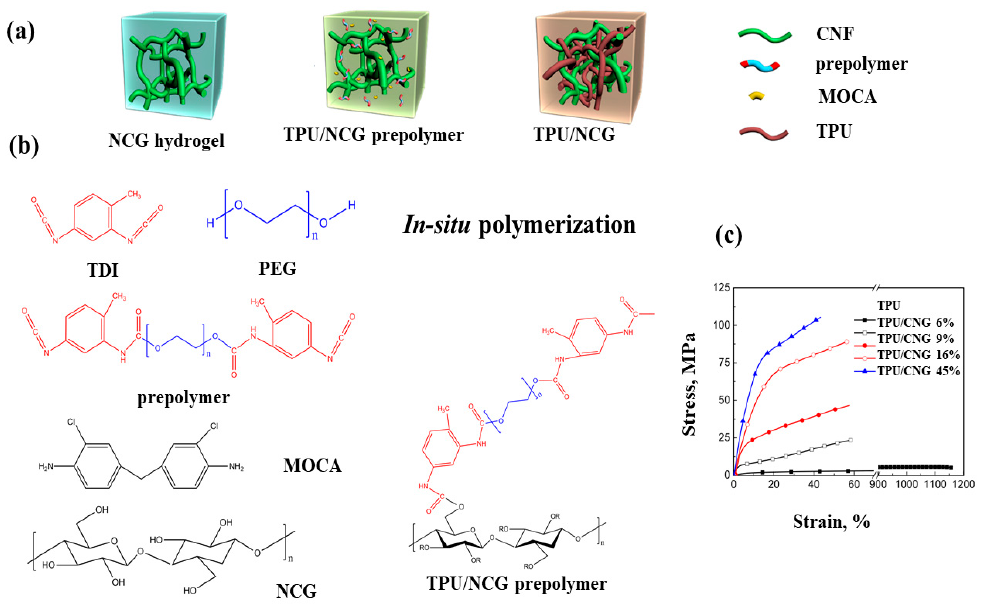
Figure 15. Preparation of double-network TPU/NCG nanocomposites. NCG hydrogel is solvent-exchanged with acetone, THF, and then a mixture of TPU prepolymer and MOCA to form NCG-TPU prepolymer-MOCA gel. In situ polymerization yielded the TPU/NCG nanocomposite ( a ), schematic illustration of the synthetic procedure of the TPU/NCG nanocomposite ( b ), and typical stress − strain curves of neat TPU and TPU/NCG nanocomposites containing 9 vol% NCG ( c ). Adapted from [158].